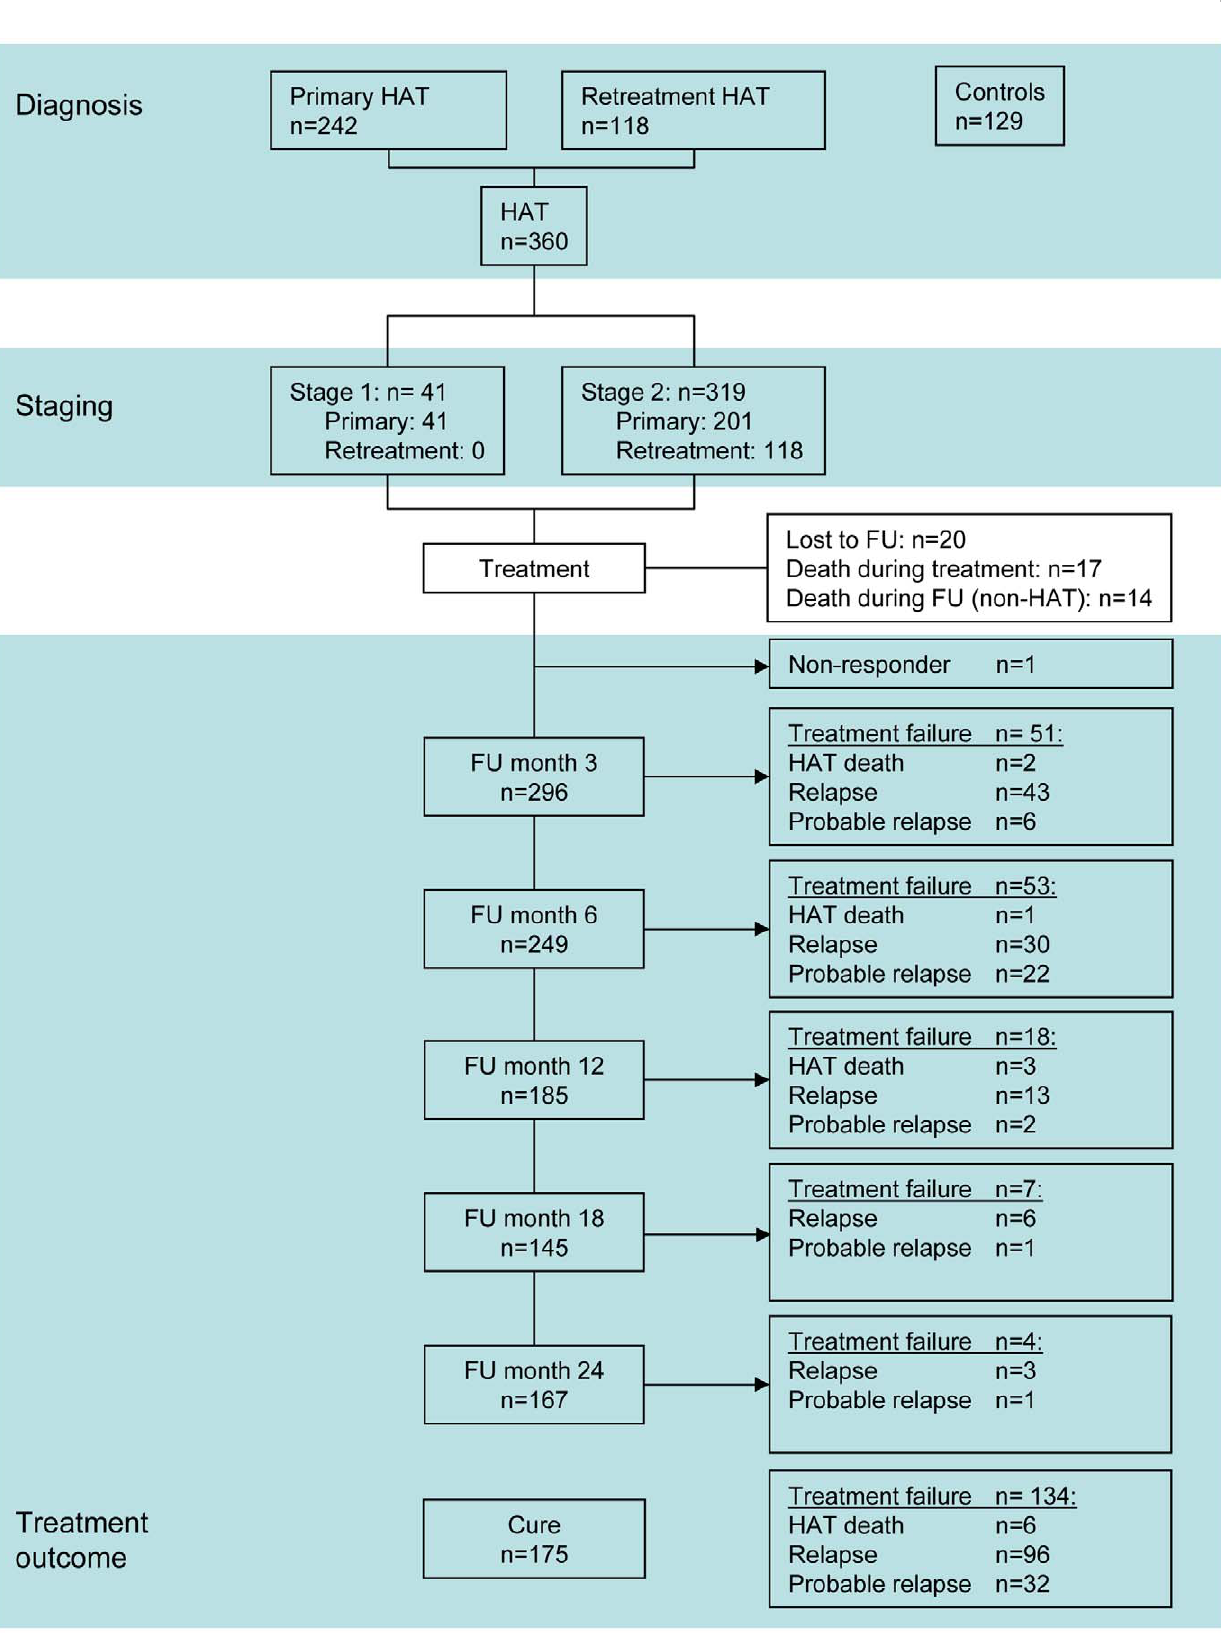
Figure 1. Classification of study participants according to reference standards for diagnosis, staging and follow-up (FU). At each follow-up time point, the number of patients attending is given. Patient groups reaching a final outcome of treatment failure during follow-up and excluded from analysis at subsequent time points, are indicated with an arrow.